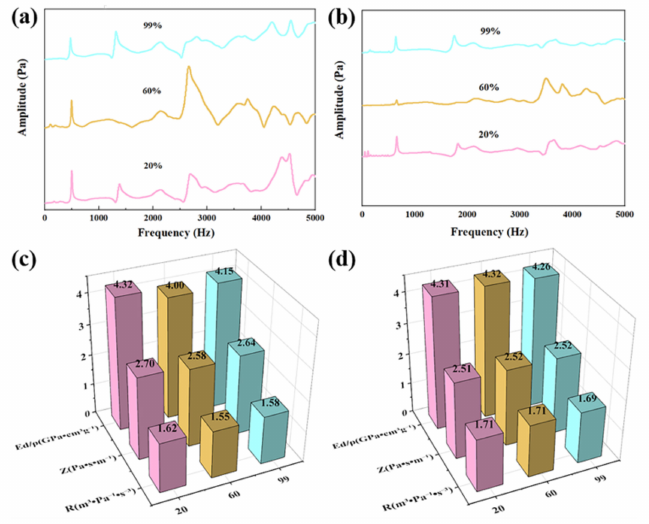
Figure 4. Frequency spectra for composites, conditioned in different RHs, reinforced with: ( a ) hemp; ( b ) ramie. Acoustic vibration performance parameters for composites reinforced with: ( c ) hemp; ( d )